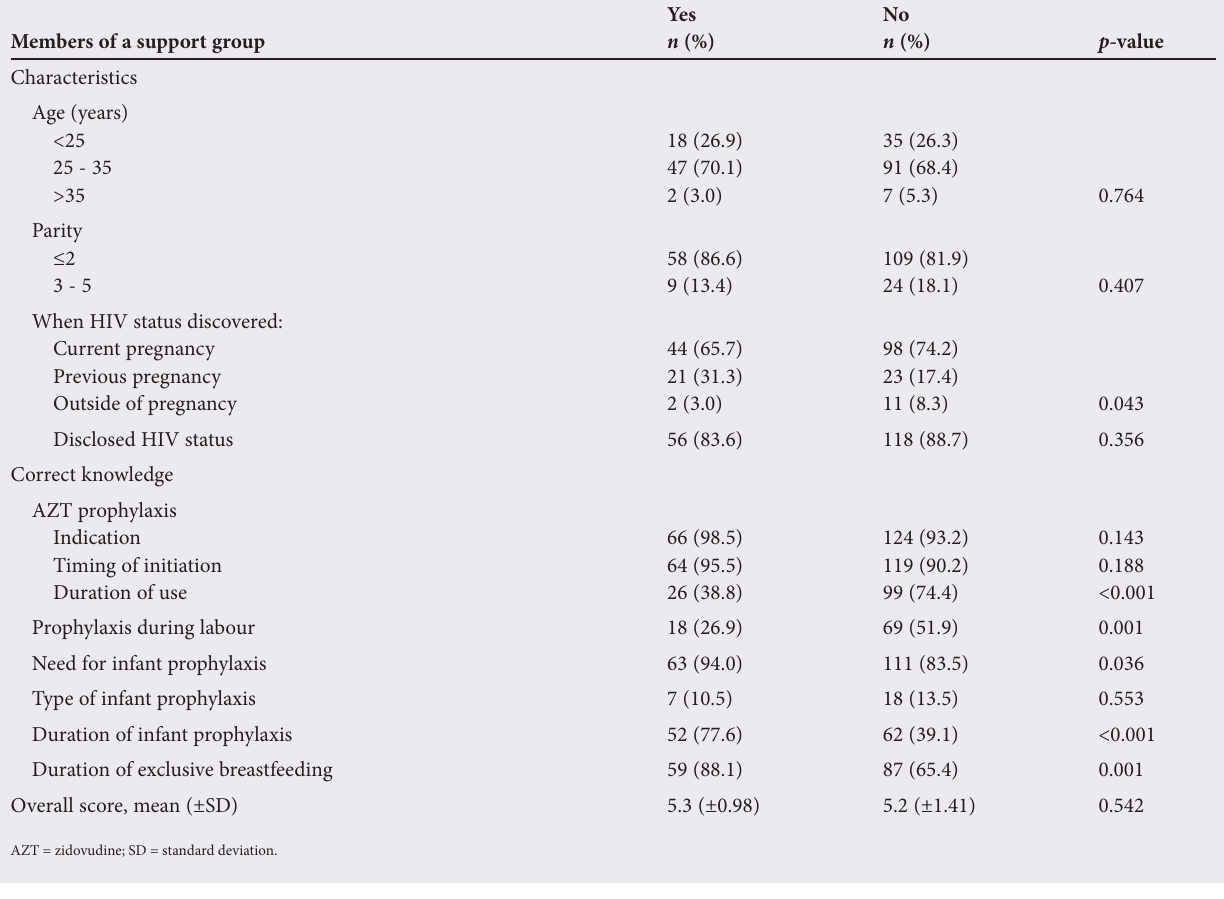
Table 2. Characteristics and knowledge of pregnant women who were members of a support group ( N =67) v. those who were not ( N =133)